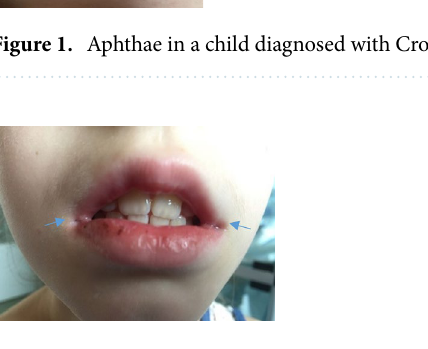
Figure 2. Angular cheilitis in a child diagnosed with ulcerative colitis.